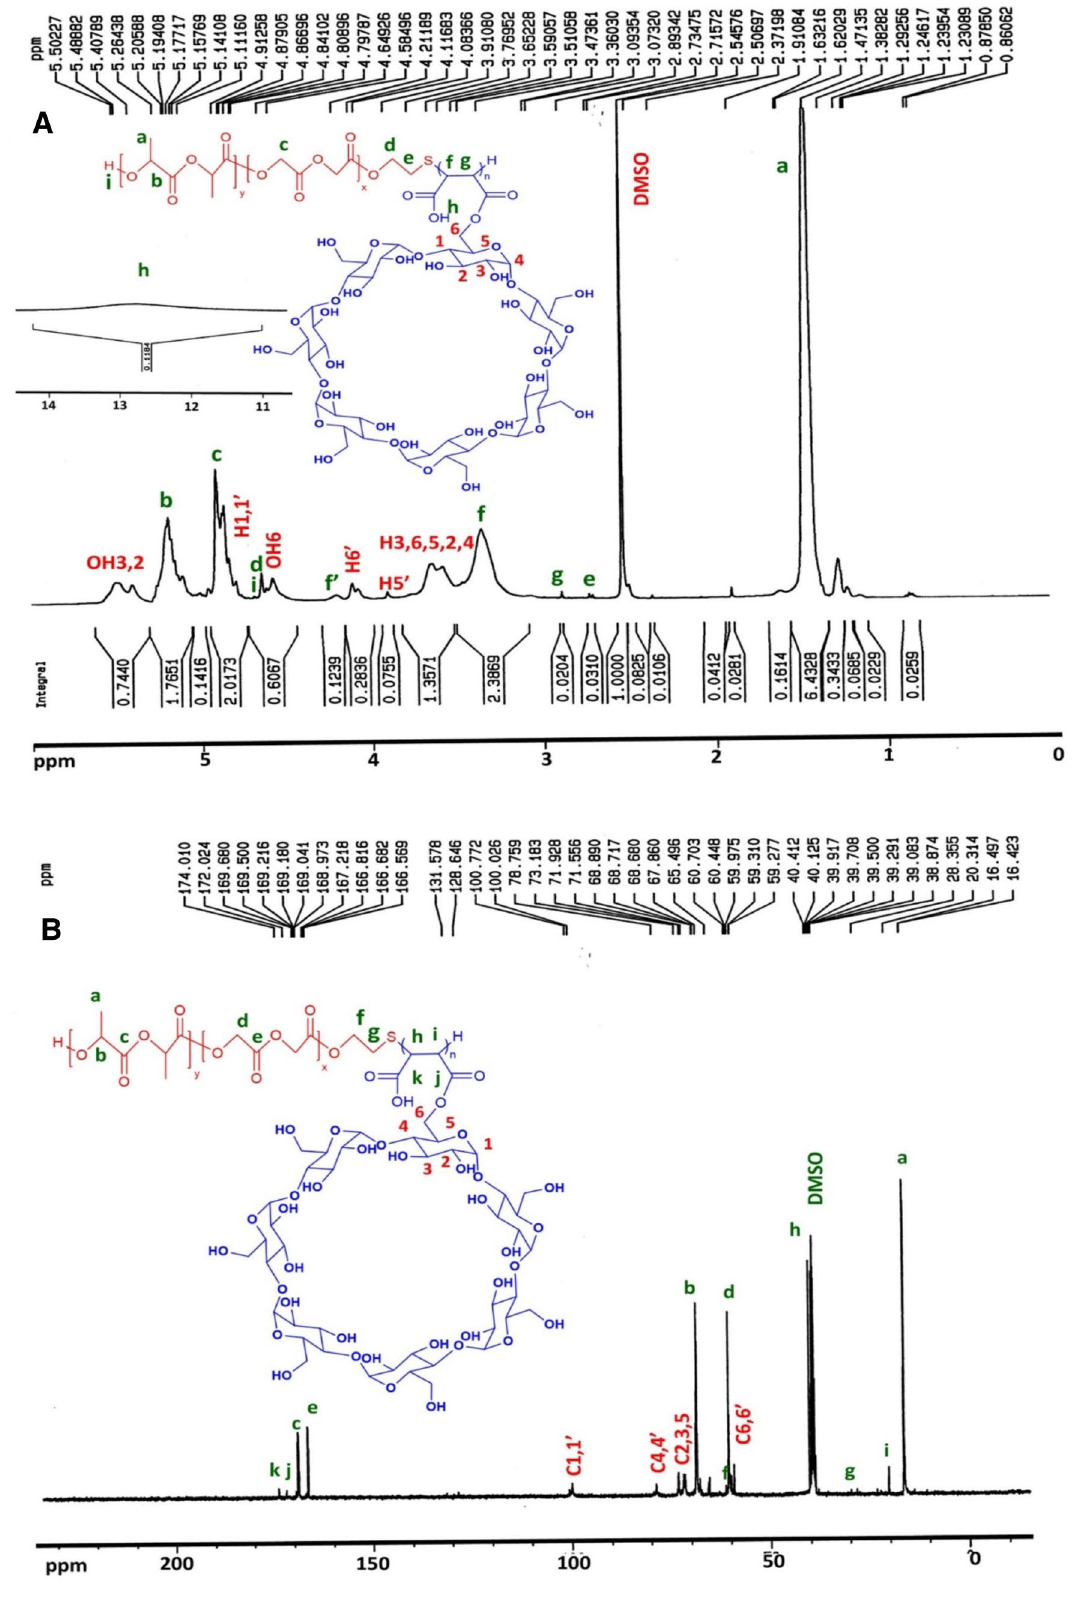
Figure 3. NMR Spectra of βCD-g-PMA-co-PLGA copolymer in DMSO-d 6 , ( A ) 1 HNMR and ( B ) 13 CNMR